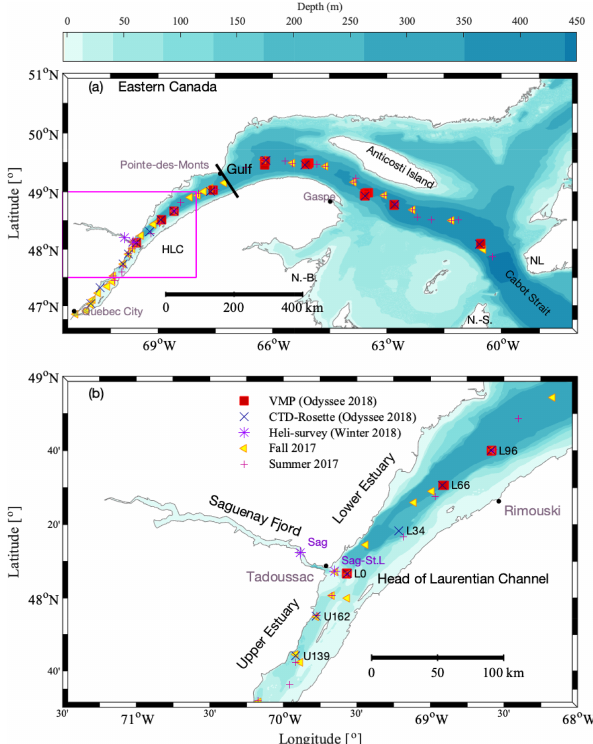
Figure 1. (a) Map of the estuary and the Gulf of St. Lawrence along with the stations visited with VMPs indicated by red squares and CTD profiles with black × symbols. Station L96 coincides with a long-term monitoring station of Fisheries and Oceans Canada’s Atlantic Zone Monitoring Program (AZMP), Rimouski station. (b) Enlargement of the magenta inset in (a) to illustrate the head of the channel region and two Saguenay stations surveyed by heli- copter in March